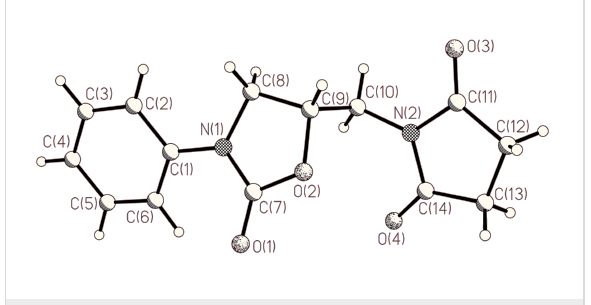
Figure 1: Structure of oxidation product 10a in the crystal.